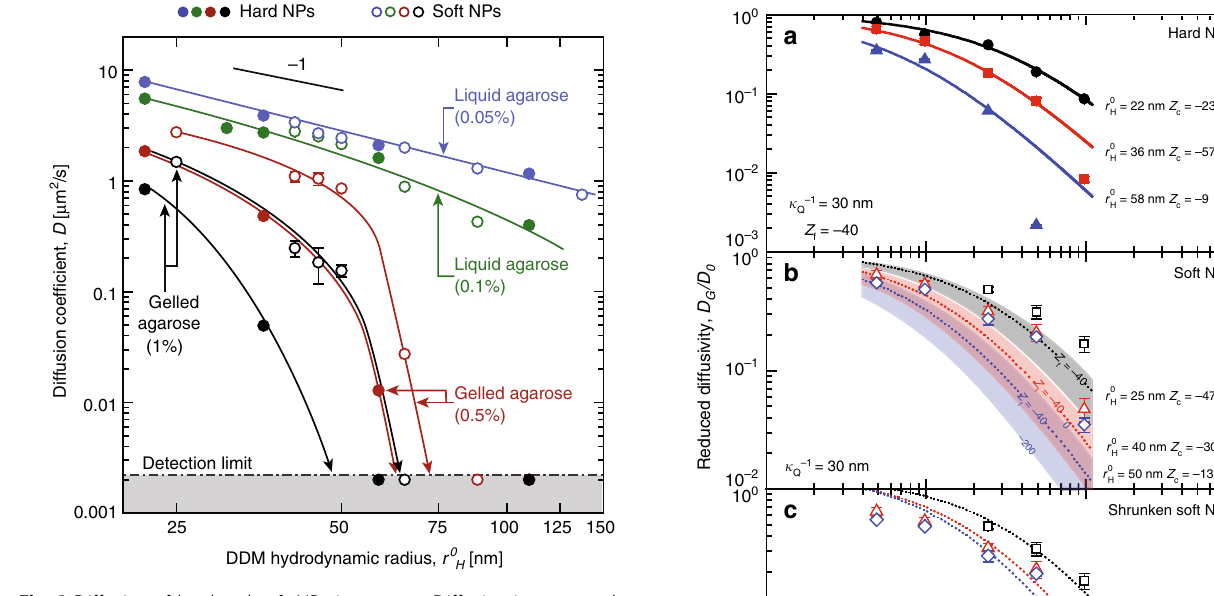
Fig. 2 Diffusion of hard and soft NPs in agarose. Diffusion is compared at different concentrations of agarose ( C ag = 0.05, 0.1, 0.5, 1% w/w) versus the hydrodynamic radius r 0 H measured in water by DDM. Solid lines are guides to the eye, while the grey area shows the region below the detection limit, also indicating NP immobilization. Each point is presented with an error bar that corresponds to an average of 5 – 7 DDM measurements on one sample and its standard deviation